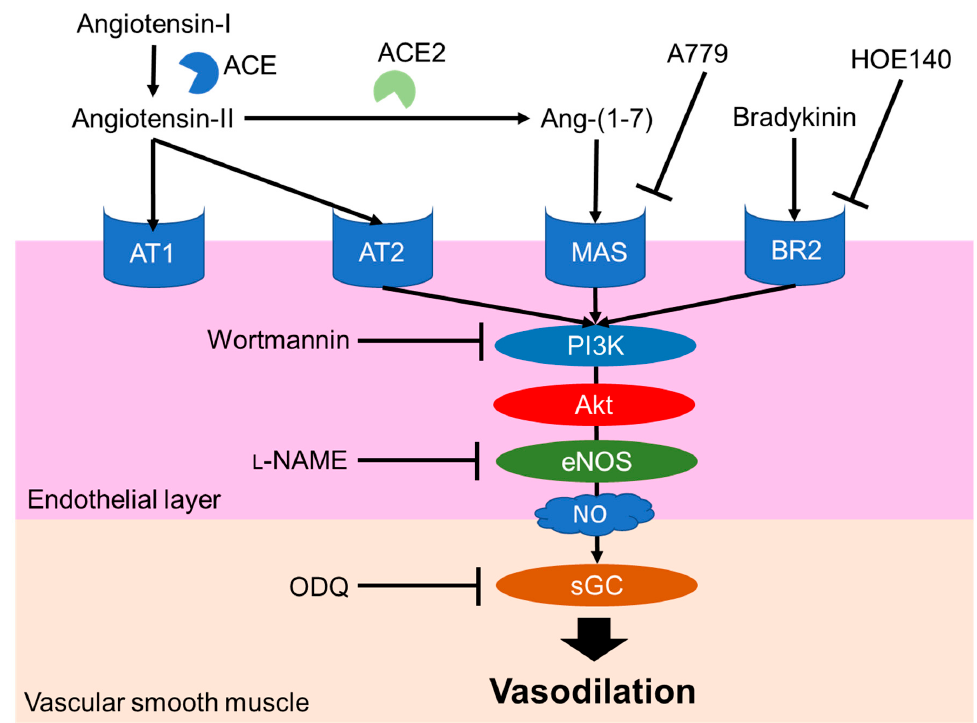
Figure 3. Major NO-mediated vasodilation pathways. Endogenous peptide hormones activate NO production by the phosphorylation of PI3K, Akt and eNOS. sGC, soluble guanylate cyclases; NO, nitric oxide; eNOS, endothelial nitric oxide synthase; Akt, protein kinase b; BR2, Bradykinin receptor B2, L-NAME, N(G)-nitro-L-arginine methyl ester